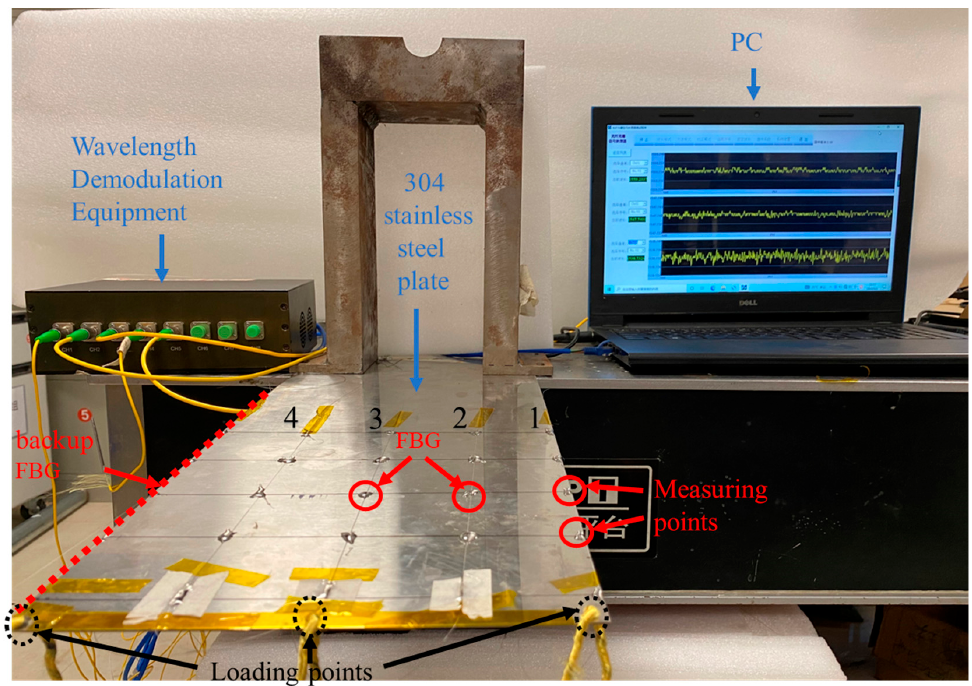
Figure 9. Testing System for Deformation Monitoring and Shape Reconfiguration of Flexible Structural.